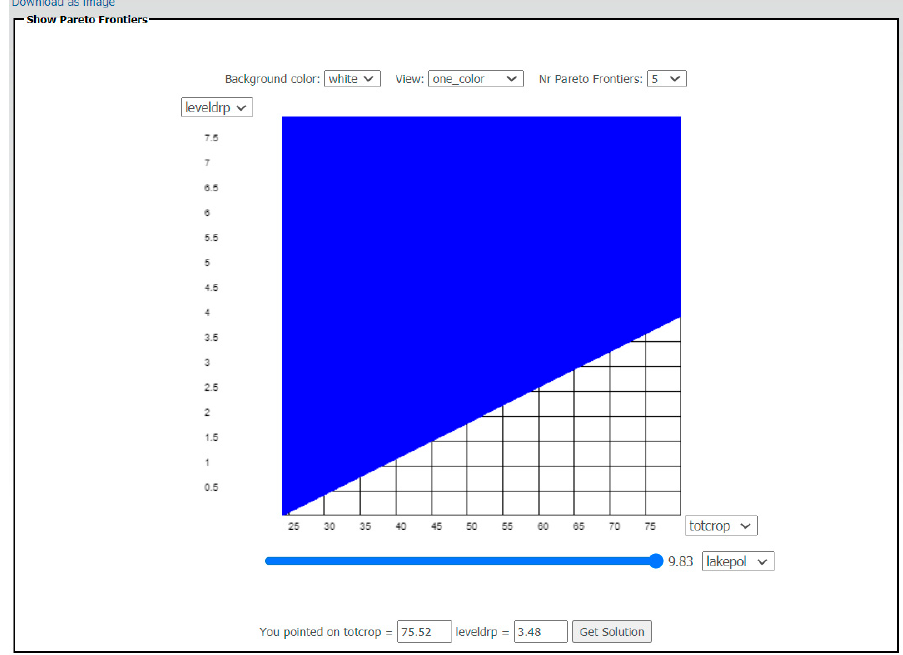
Figure 7. Representation of Pareto frontier with only one frontier (one color) with tradeoffs between totcrop (in %) and leveldrp (in mg L − 1 ) and the lakepol (in %) defined by the movement of the slider.